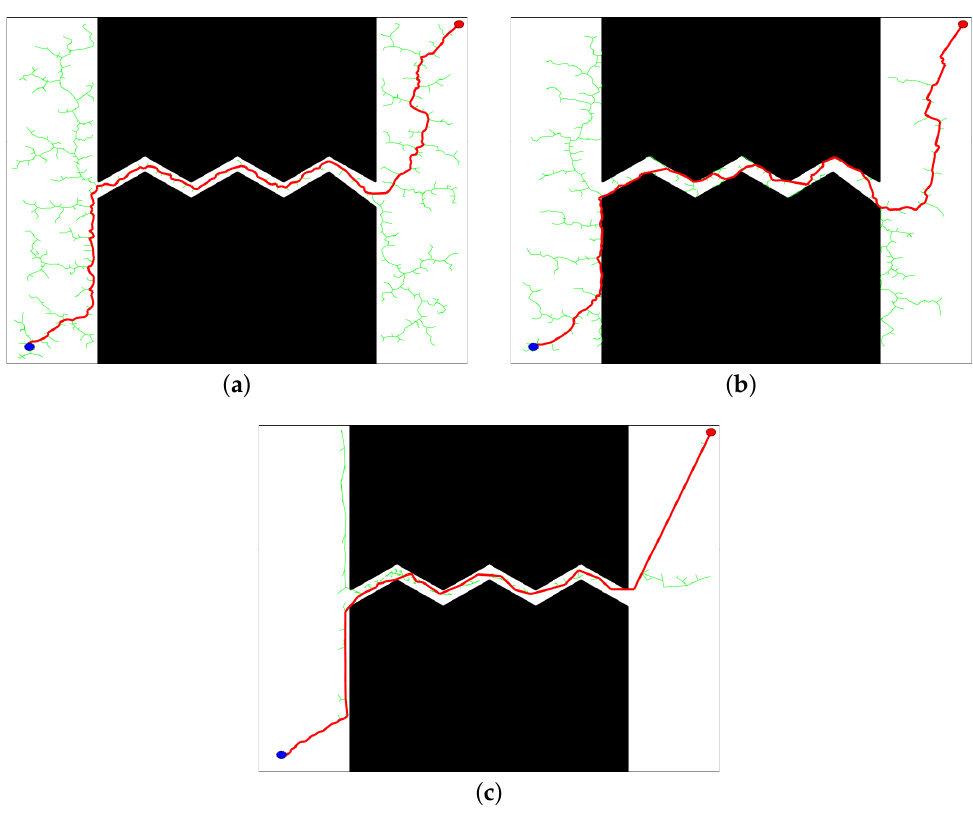
Figure 9. The performance of the three algorithms in narrow passage. ( a ) RRT; ( b ) RRV; ( c ) RJ-RRT. Table 2. Results of three algorithms in narrow